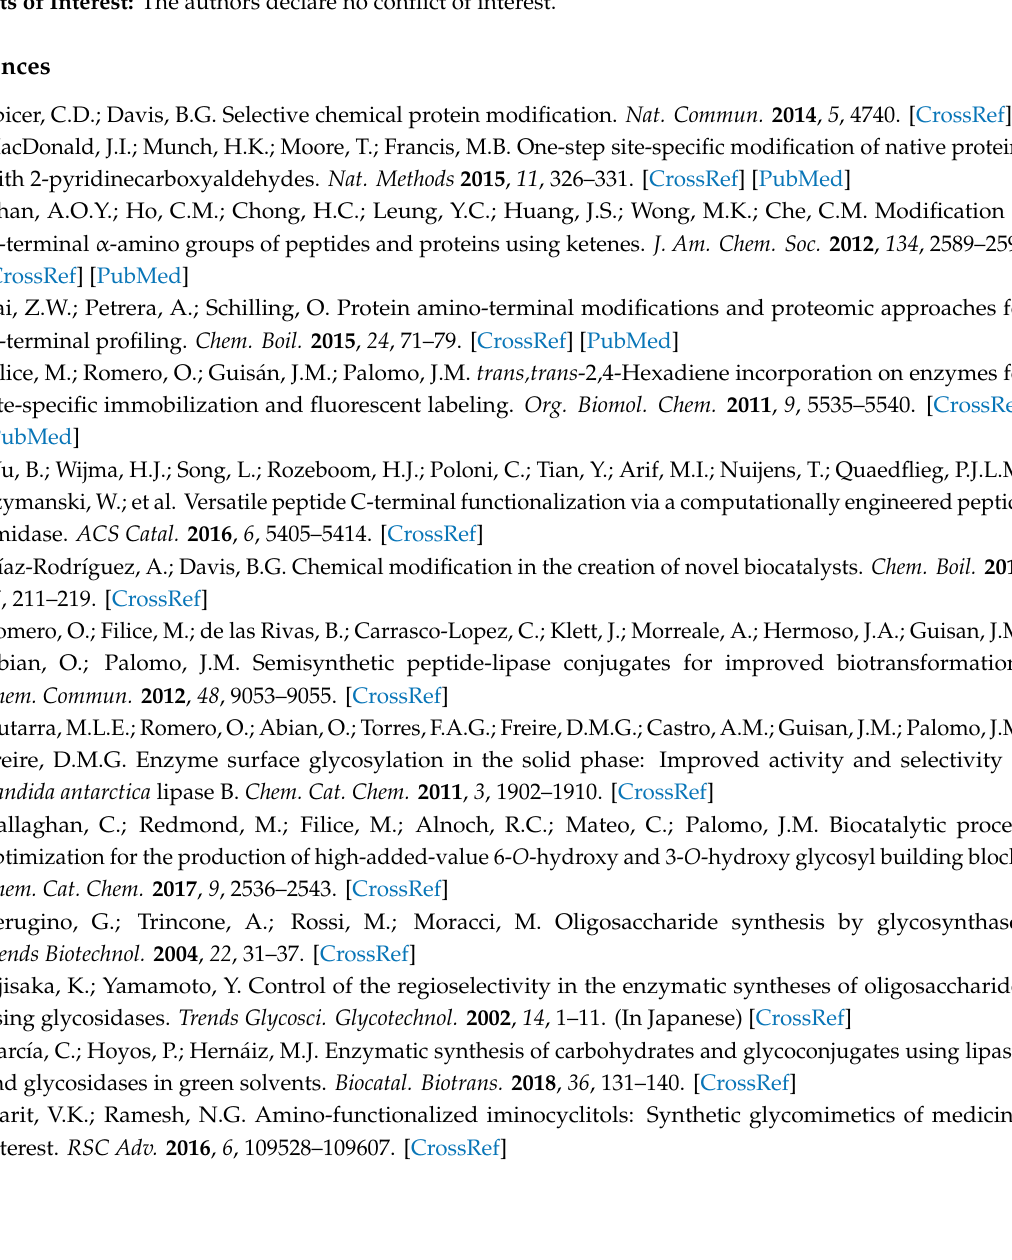
Figure S1: Lp_0440 structure incorporating a His6-tag in the C-terminus; Figure S2: Di ff erences on the hyaluronic acid (HA) chemical modification of glycosidases containing a His6-tag in the N- or C-terminus; Figure S3: Lp_0440 surface tridimensional